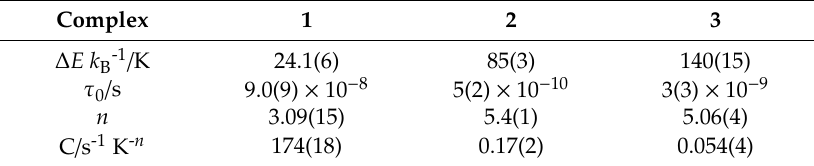
Table 1. Best fit kinetic parameters for magnetization flipping estimated for complexes 1 – 3 on the basis of the Equation